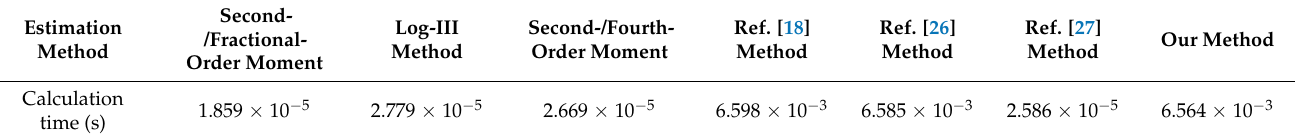
Table 4. The calculation time in simulated K-distribution ( k =